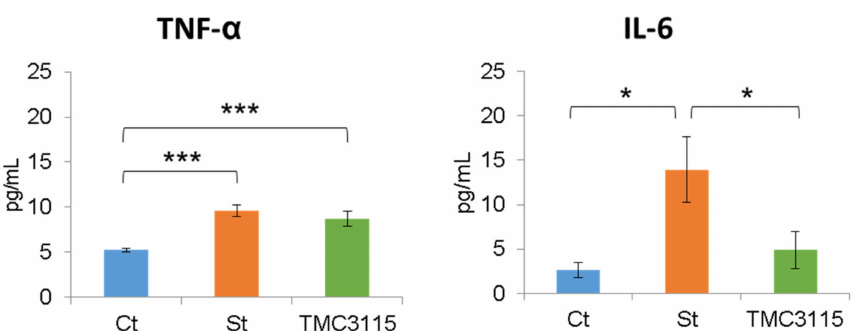
Figure 5. Serum levels of TNF- α and IL-6. Ct: control mice; St: unsupplemented sCSDS mice; TMC3115: sCSDS mice supplemented with TMC3115. Bars represent mean ± SE. * indicates signifi- cant differences between groups, * p < 0.05, *** p <